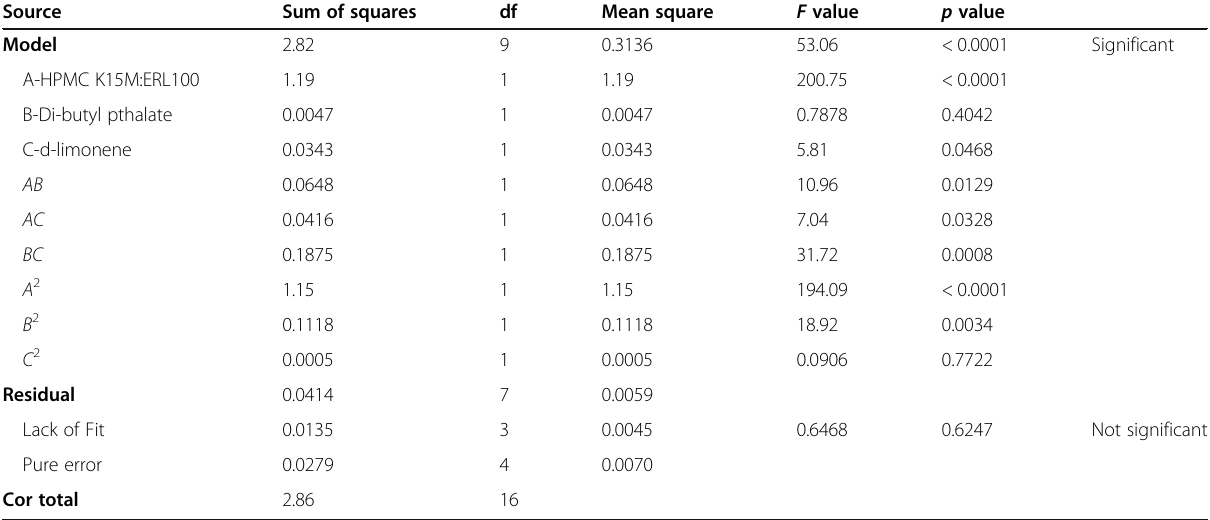
Table 4 ANOVA for the quadratic model (tensile strength response) Source